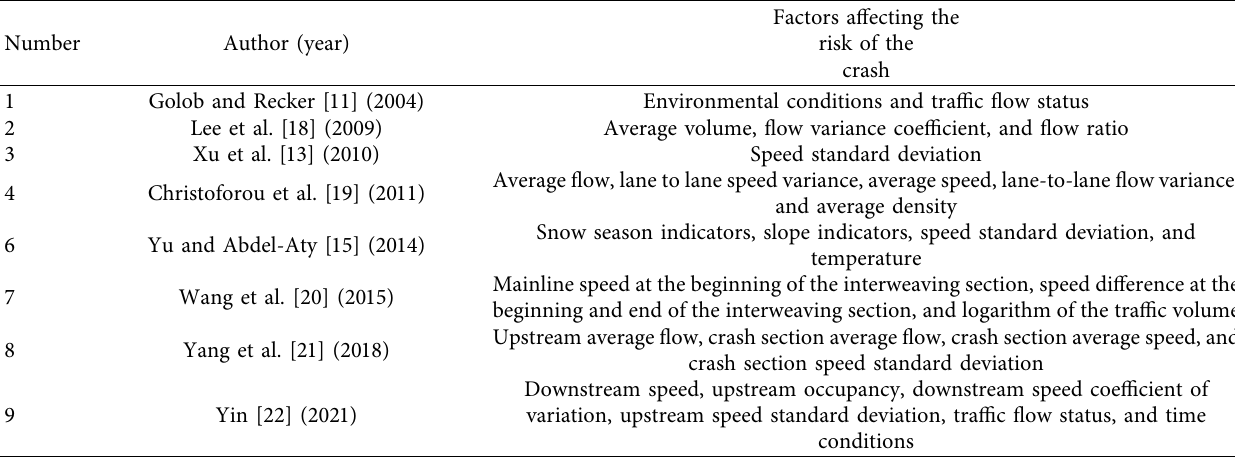
Table 1: Real-time trafc crash precursors obtained from some research